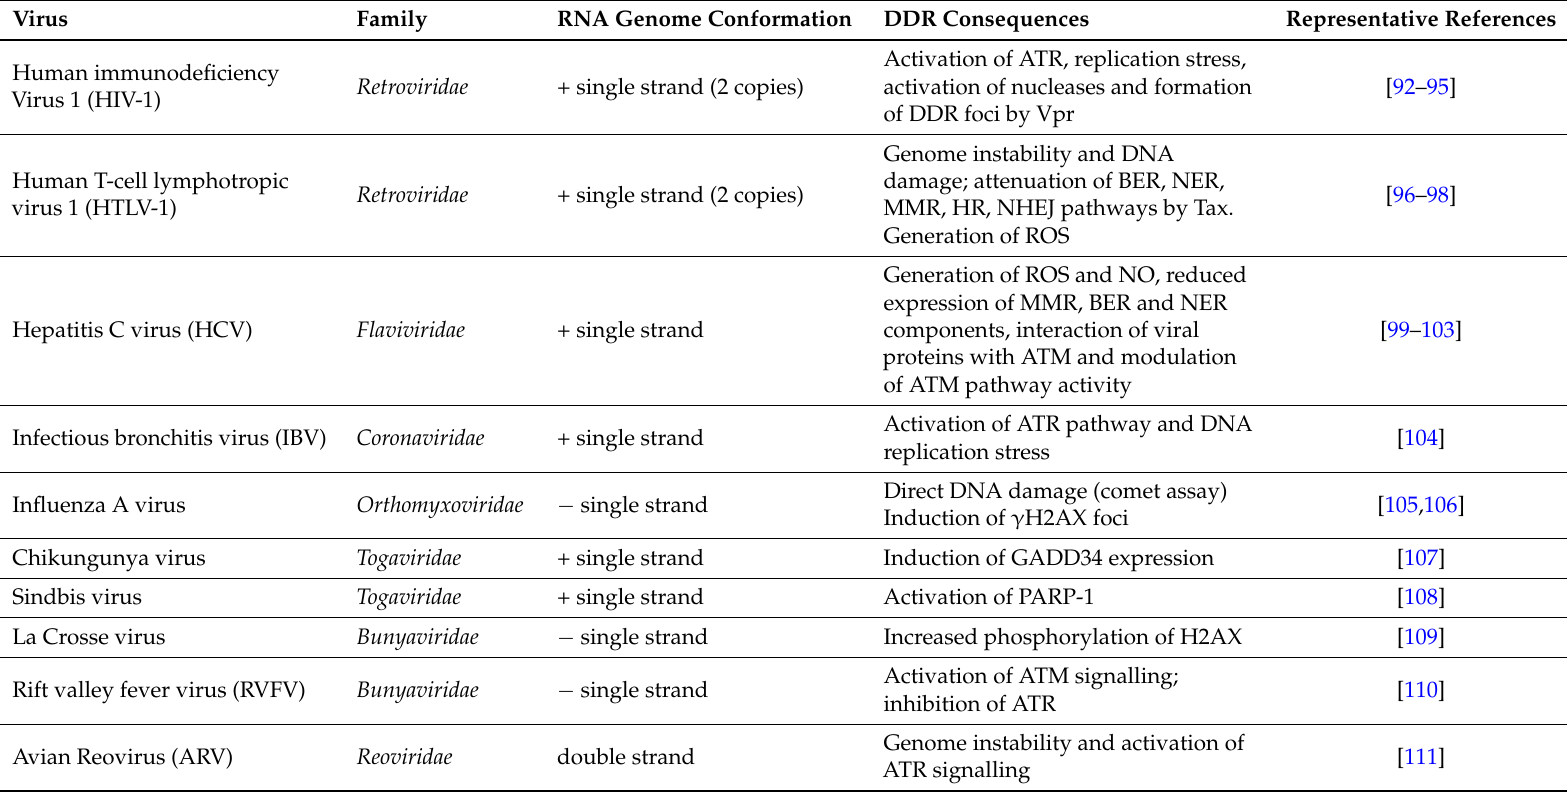
Table 1. Overview of several RNA viruses which impact on the cellular